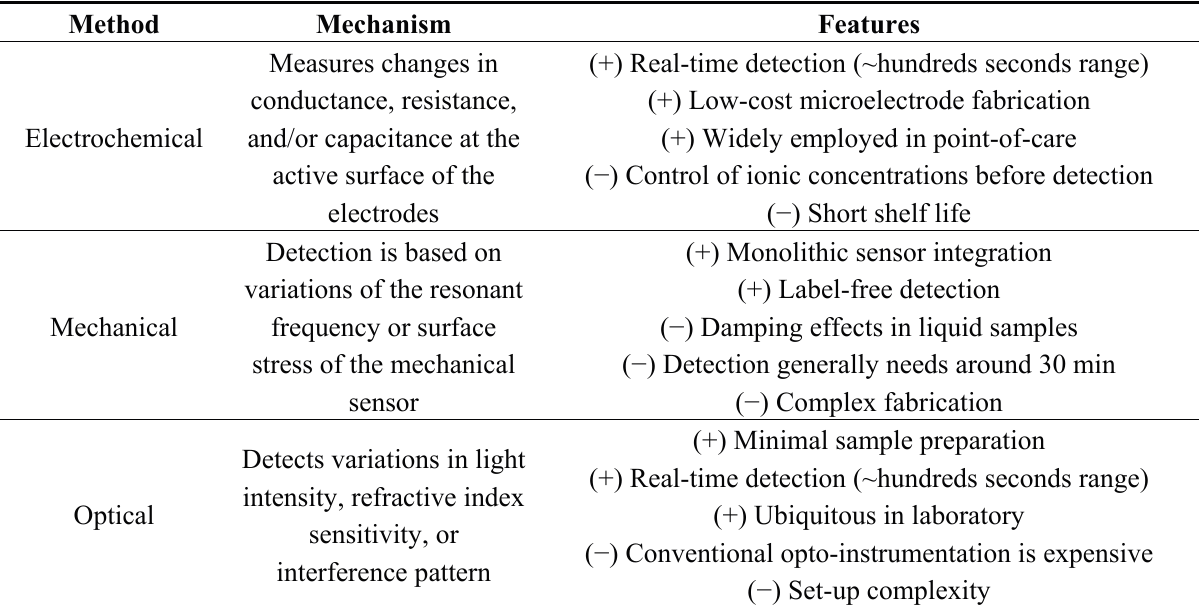
Table 1. Summary of the electrochemical [18], mechanical [19] and optical detection [20] technologies employed in microfluidic